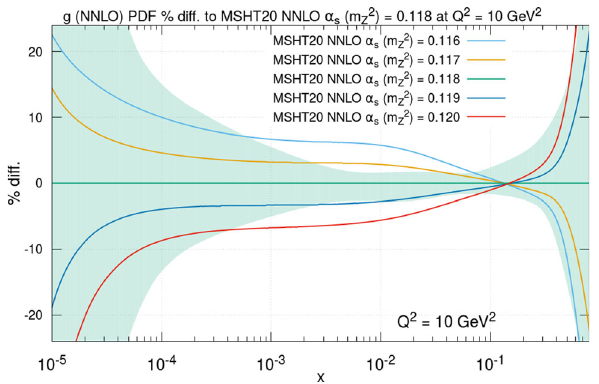
Fig. 10 Percentage difference in the NNLO gluon PDF at the lower scale of Q 2 = 10 GeV 2 relative to the central (α S ( M 2 for fits with different values of α S . The percentage error bands for the central set are